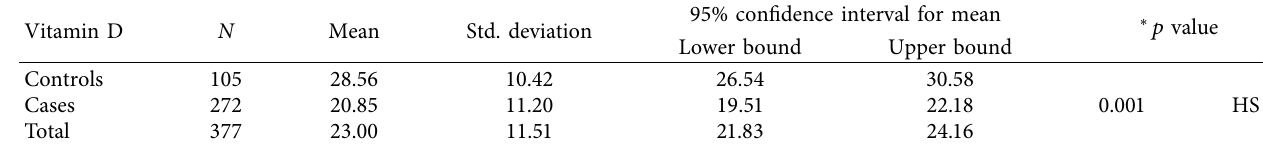
Table 3: Comparison of the mean vitamin D levels in the caries-free and caries-active groups. Vitamin D